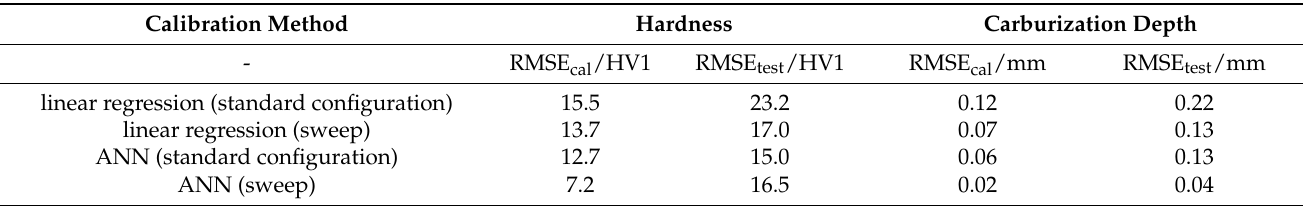
Figure 15. Correlation of micromagnetic determined (linear regression) and actual measured hardness of calibration and test data set with standard configuration ( a ) and use of sweeps ( b ). Table 11. Standard error based on a test data set of 14 samples for calibration with standard configuration and use of